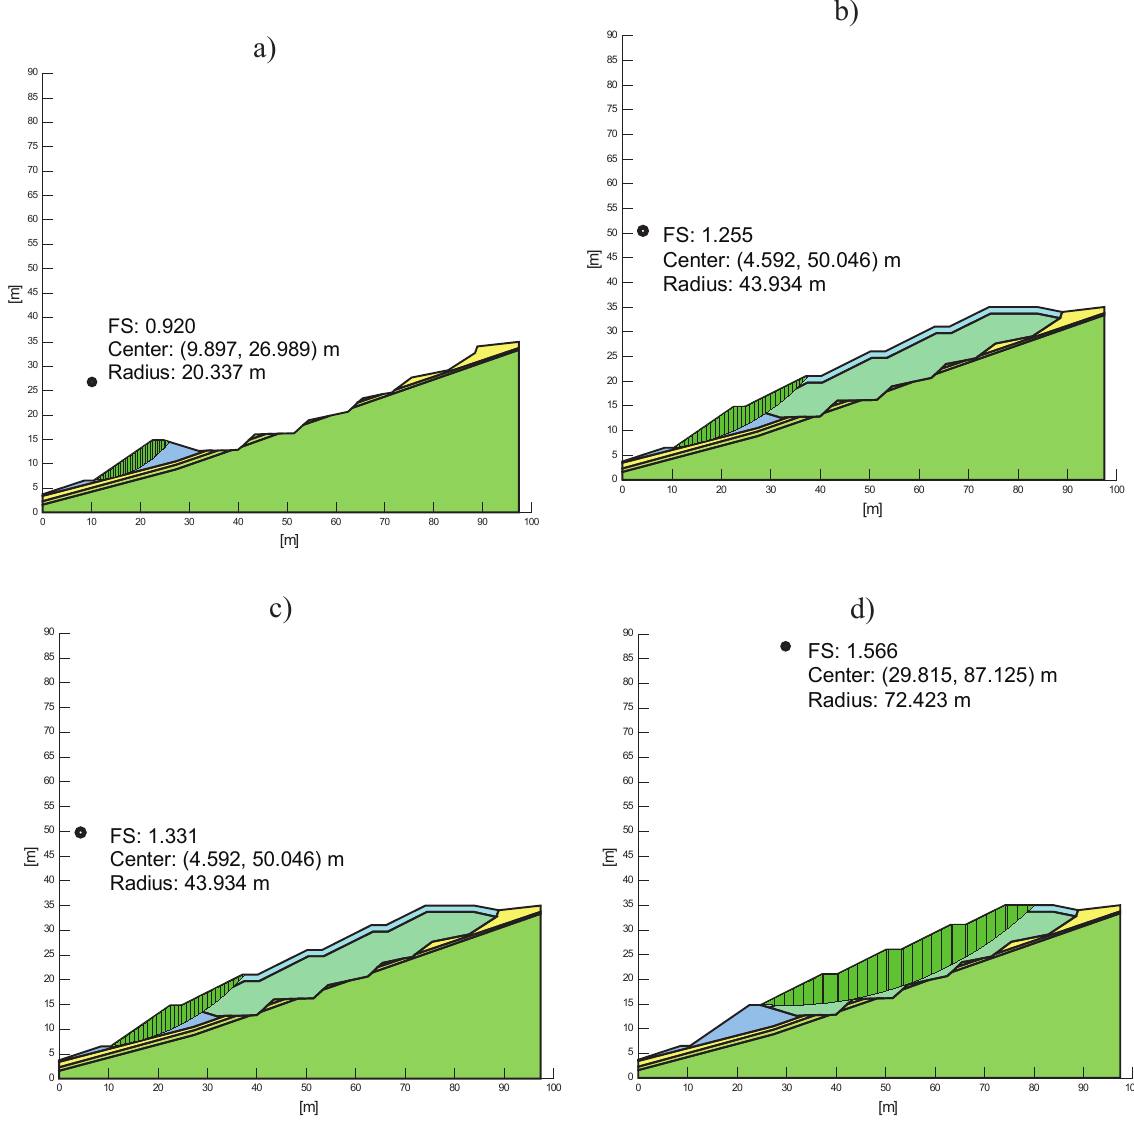
Fig. 10. Selected stability analysis results (Bishop’s method) Figure 10 : Selected stability analysis results (Bishop’s method): a) only the retaining embankment 2004, b) 2009, c) 2011 and d) 2013, 2015 and 2017 (identical